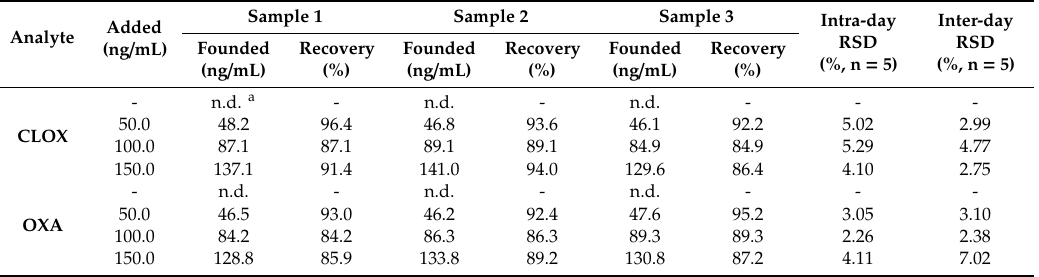
Figure 11. Electropherograms of the blank water sample ( a ), the blank river water sample spiked with 50 ng / mL ( b ), the blank river water sample spiked with 100.0 ng / mL ( c ). Conditions: the amount of PPy-PA6-NFsM, 10.0 mg; sample volume, 40.0 mL; sample pH, 4.0; extraction time, 30 min; eluent, 2.0 mL of 2% ammonia / ACN ( v / v ); desorption time, 30 min. Table 3. Determination of the two β -lactams and their recoveries from river water